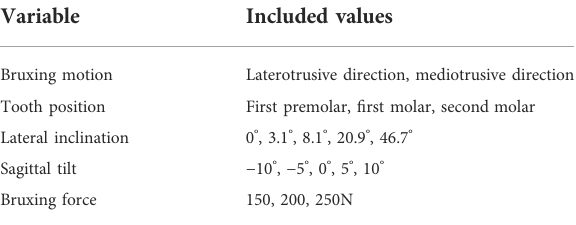
TABLE 1 Overview of variables included in the